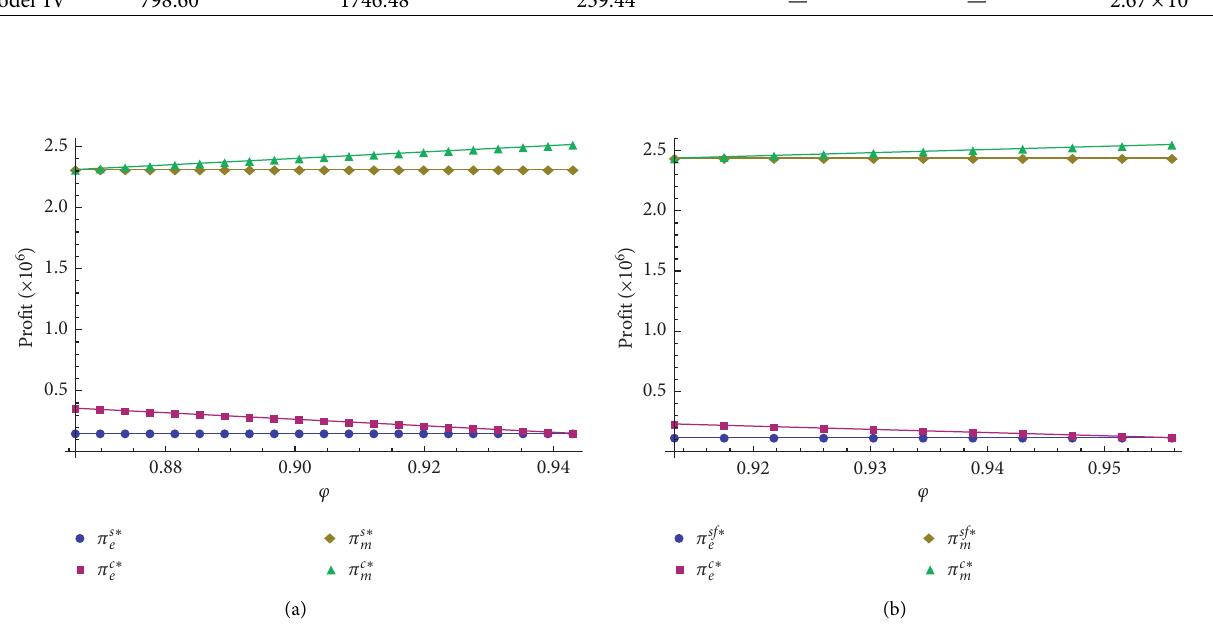
Figure 1: Comparison before and after coordination: (a) without fairness concerns; (b) with fairness concerns.